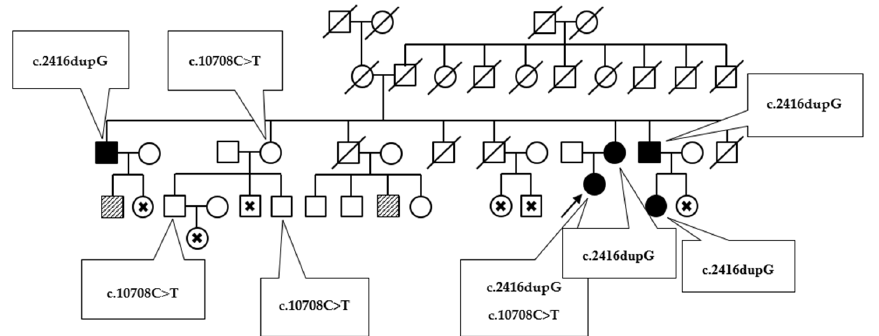
Figure 4. The diagram presents the inheritance of variants c.2416dupG and c.10708C>T in the proband’s family. Phenotypically affected members are marked by black. Patients with slightly elevated total cholesterol level are flagged by a diagonal slash. Examined patients with no clinical symptoms are marked with a cross.